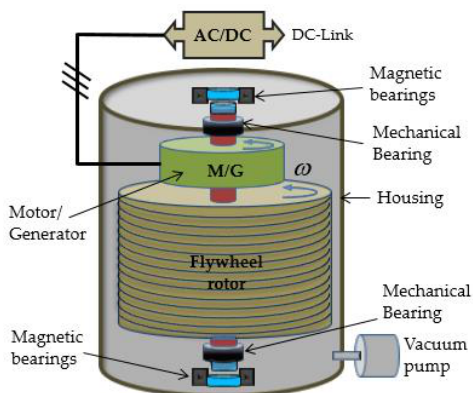
Figure 1. Structure and components of flywheel energy storage system (FESS).